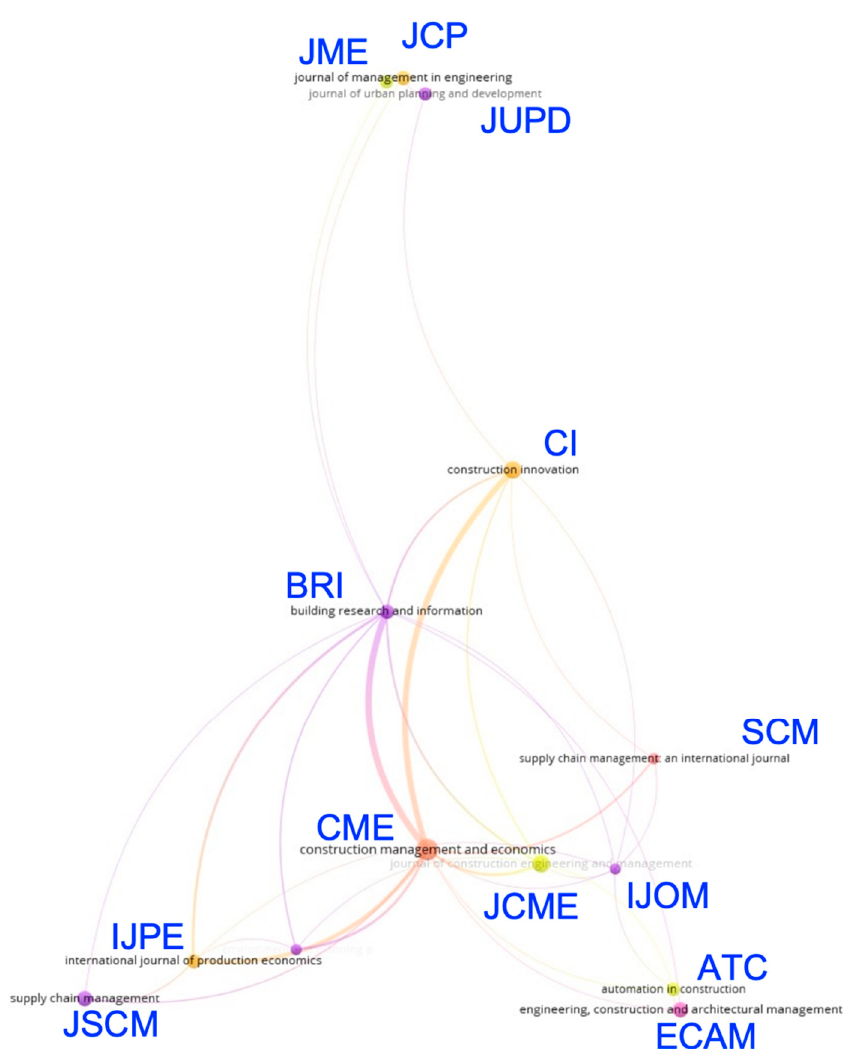
Figure 7. Network of prominent publication outlets .